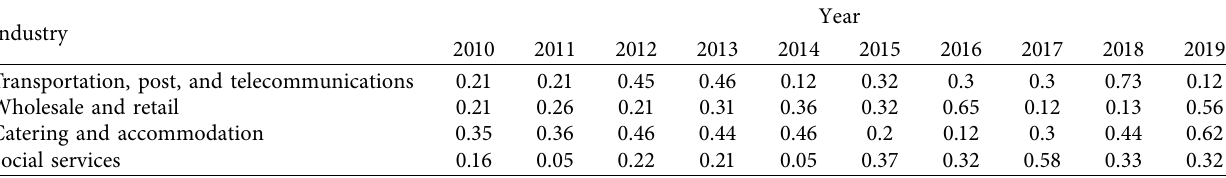
Table 1: Stripping coefficient of tourism consumption in China and its regional industries from 2010 to 2019.